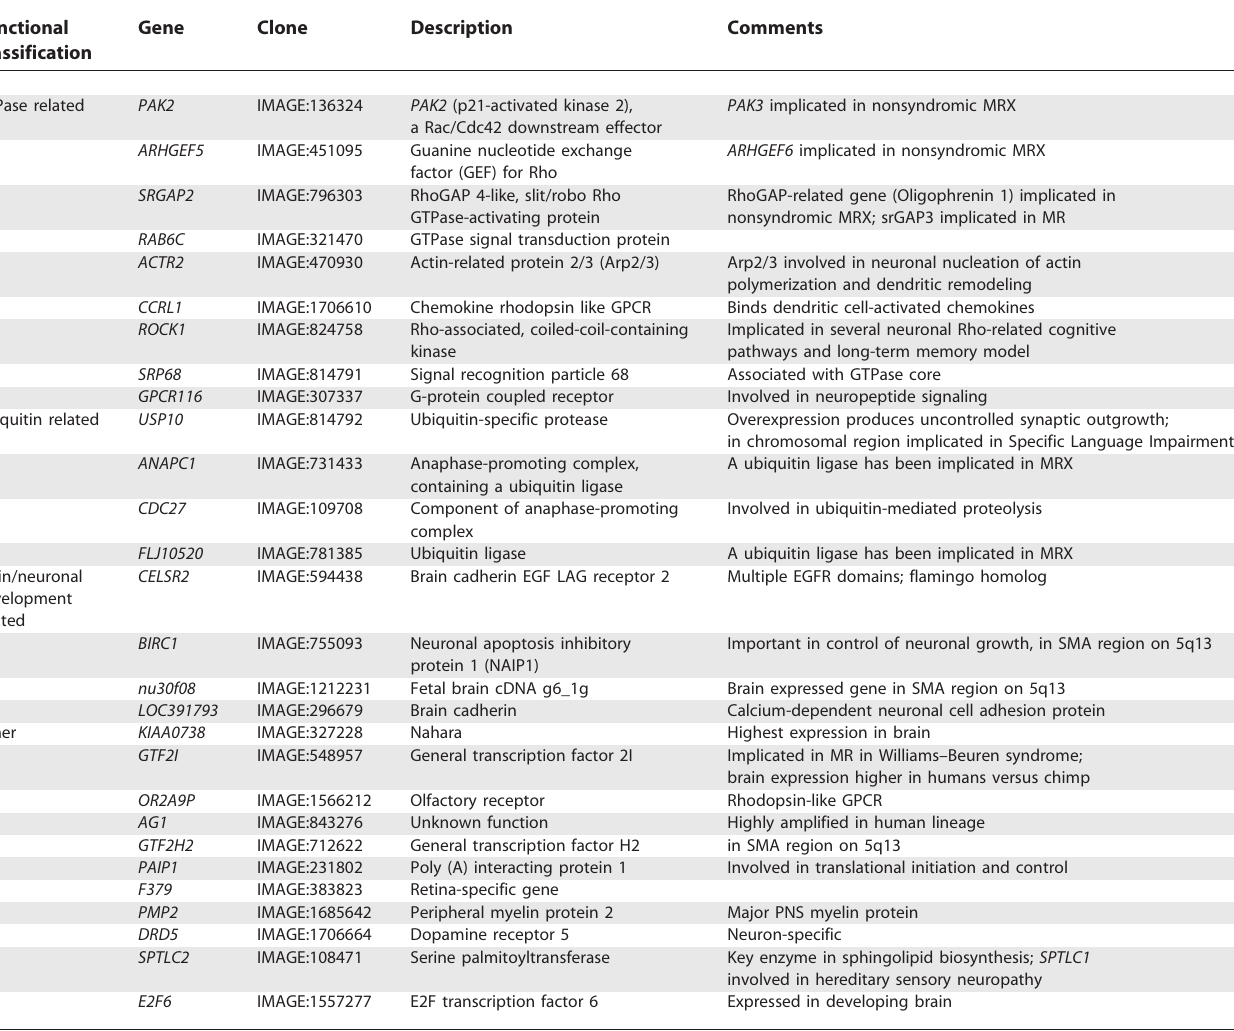
Table 4. Brain/Neuronal-Related HLS Genes Functional Classification